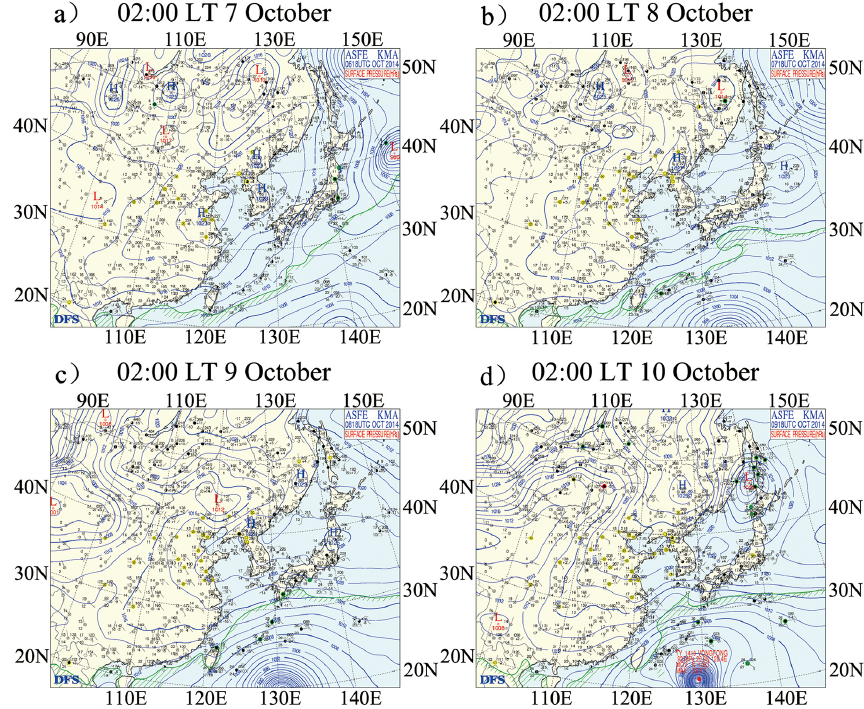
Figure 9. Surface pressure on the surface at (a) 02:00 LST 7 October, (b) 02:00 LST 8 October, (c) 02:00 LST 9 October, and (d) 02:00 LST 10 October.